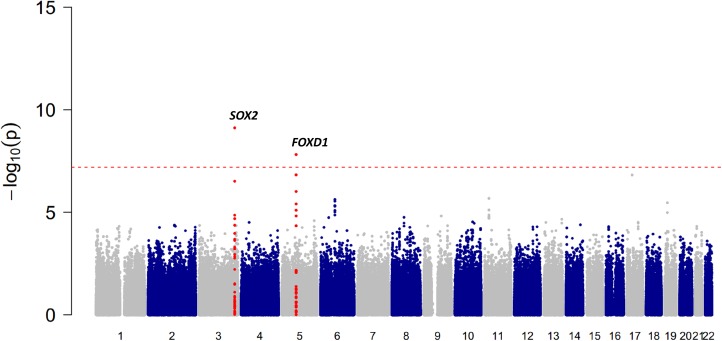
Manhattan plot showing the results of the GWAS for eyebrow thickness in Han Chinese.Manhattan plot illustrating the results of the genome-wide scan for eyebrow thickness in 2961 Han Chinese after adjusting for the top four PCs, gender and age. The red line indicates the threshold for genome-wide statistical significance (P<5×10−8). Red dots represent SNPs that are close (<5 kb) to the genome-wide significant signals.